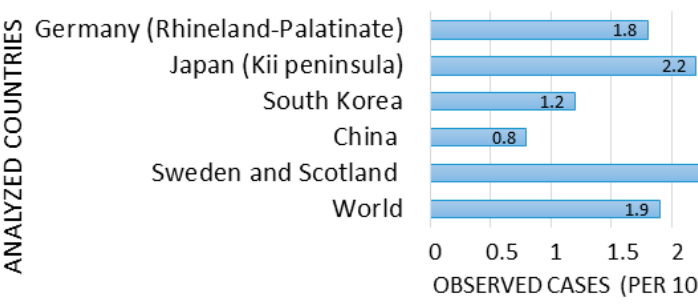
Figure 1. Incidence of Amyotrophic Lateral Sclerosis between Germany, Japan, South Korea, China, Sweden and Scotland and the World.